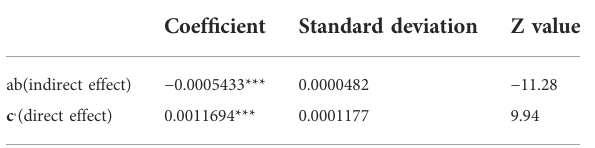
TABLE 8 Intermediation effects Bootstrap test